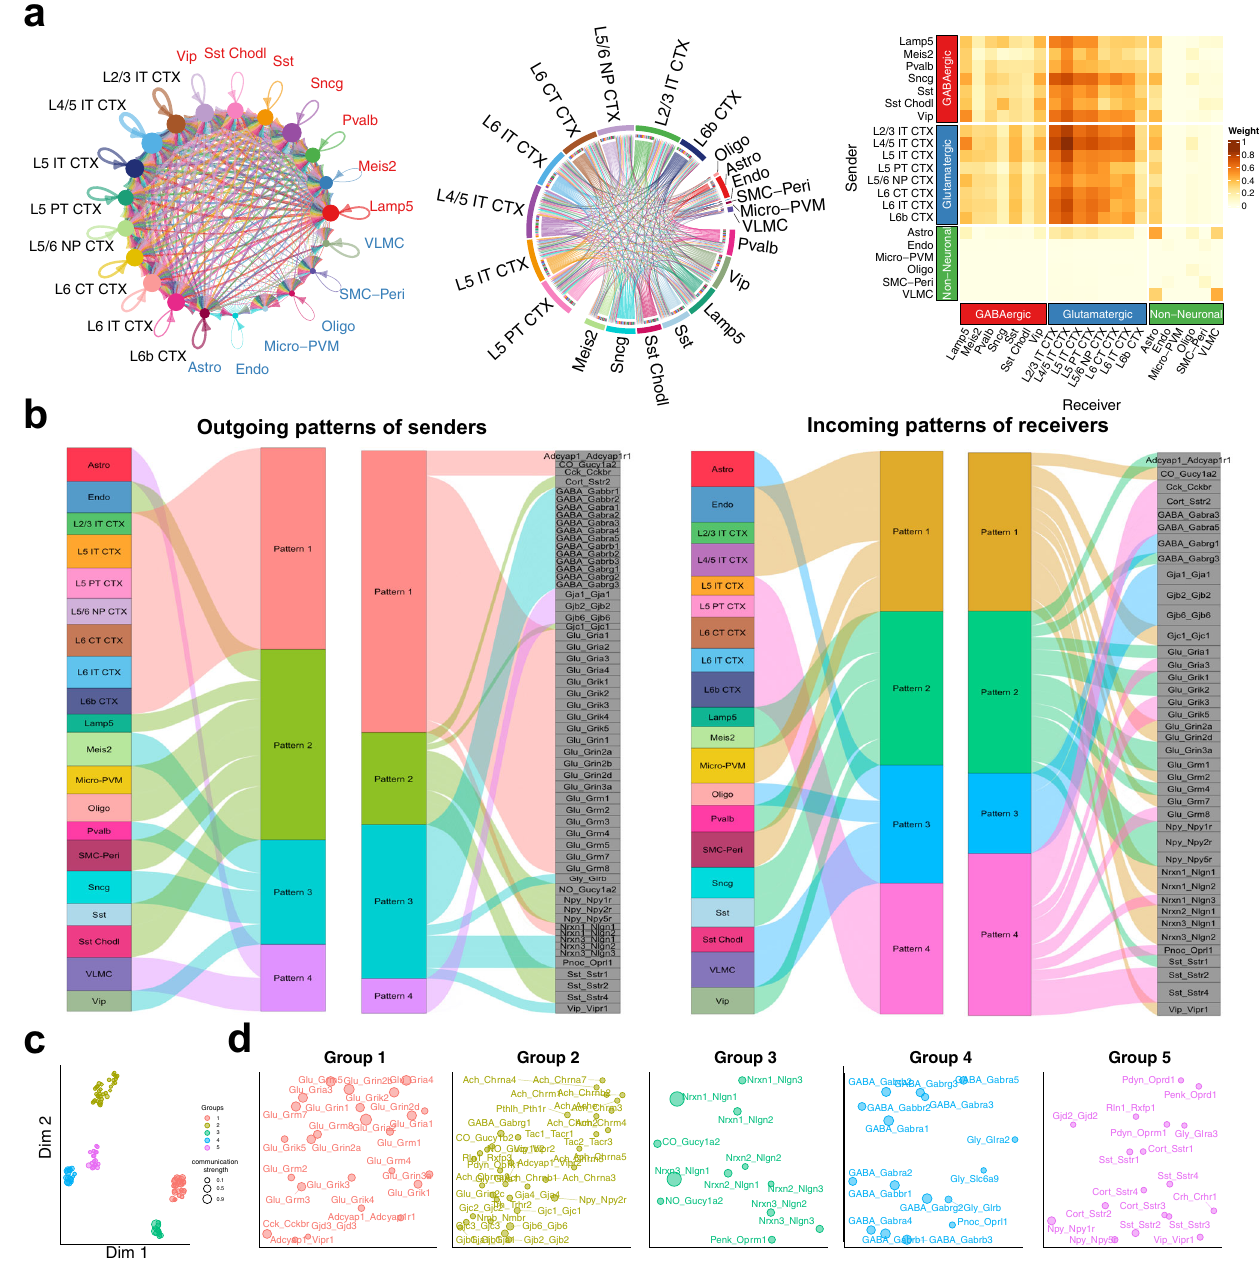
Fig. 4 |Visualizationand analysisofintercellularcommunication networksfor mouse primary visual cortex. a Visualizations of the inferred communication networks among multiple cell types of VISp. Circle plot, chord diagram and heat- mapareusedtovisualizetheintercellularcommunicationnetworksaggregatedby method “ weight ” . In the circle plot, the node size indicates the strength of the outgoing signal from the cell, and the text labels are labeled by different colors to indicate their cell classes (i.e., glutamatergic, GABAergic and non-neuronal);